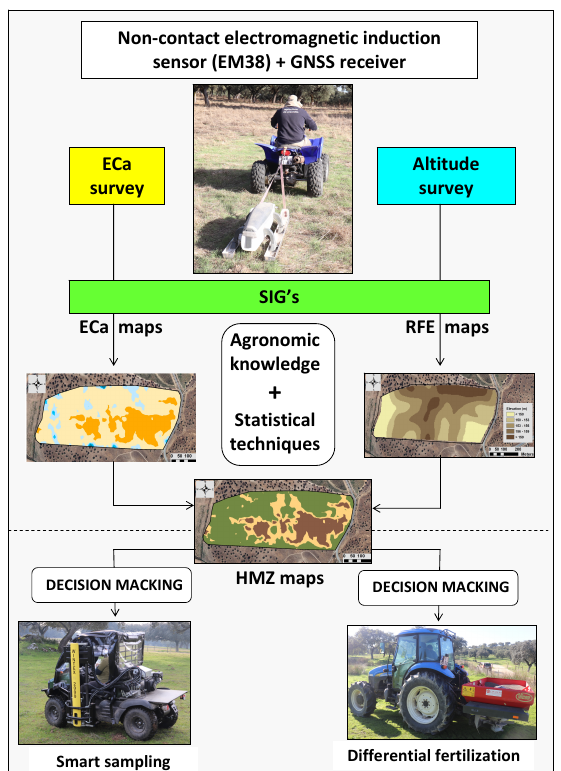
Figure 1. Schematic representation of the experimental approach used in this study.